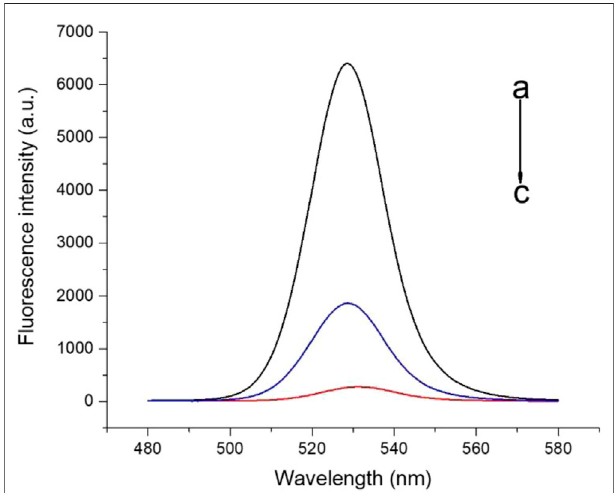
FIGURE 4 | The fl uorescence spectra of a) QD-aptamers, b) the mixture of QD-aptamers and AuNPs, and c) the hybridization of QD-aptamers and AuNPs-ssRNA (aptamer sensor).